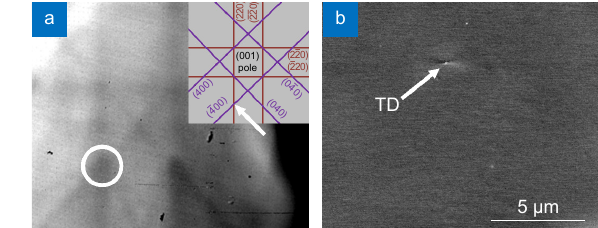
Fig. 6 | ( a ) The electron channeling patterns corresponding to the three-beam (400) and (220) imaging conditions that were used in ECCI characterization. ( b ) A representative ECCI image with only one TD. Figure repoduced with permisson from ref. 29 , under a Creat- ive Commons Attribution 4.0 International License.